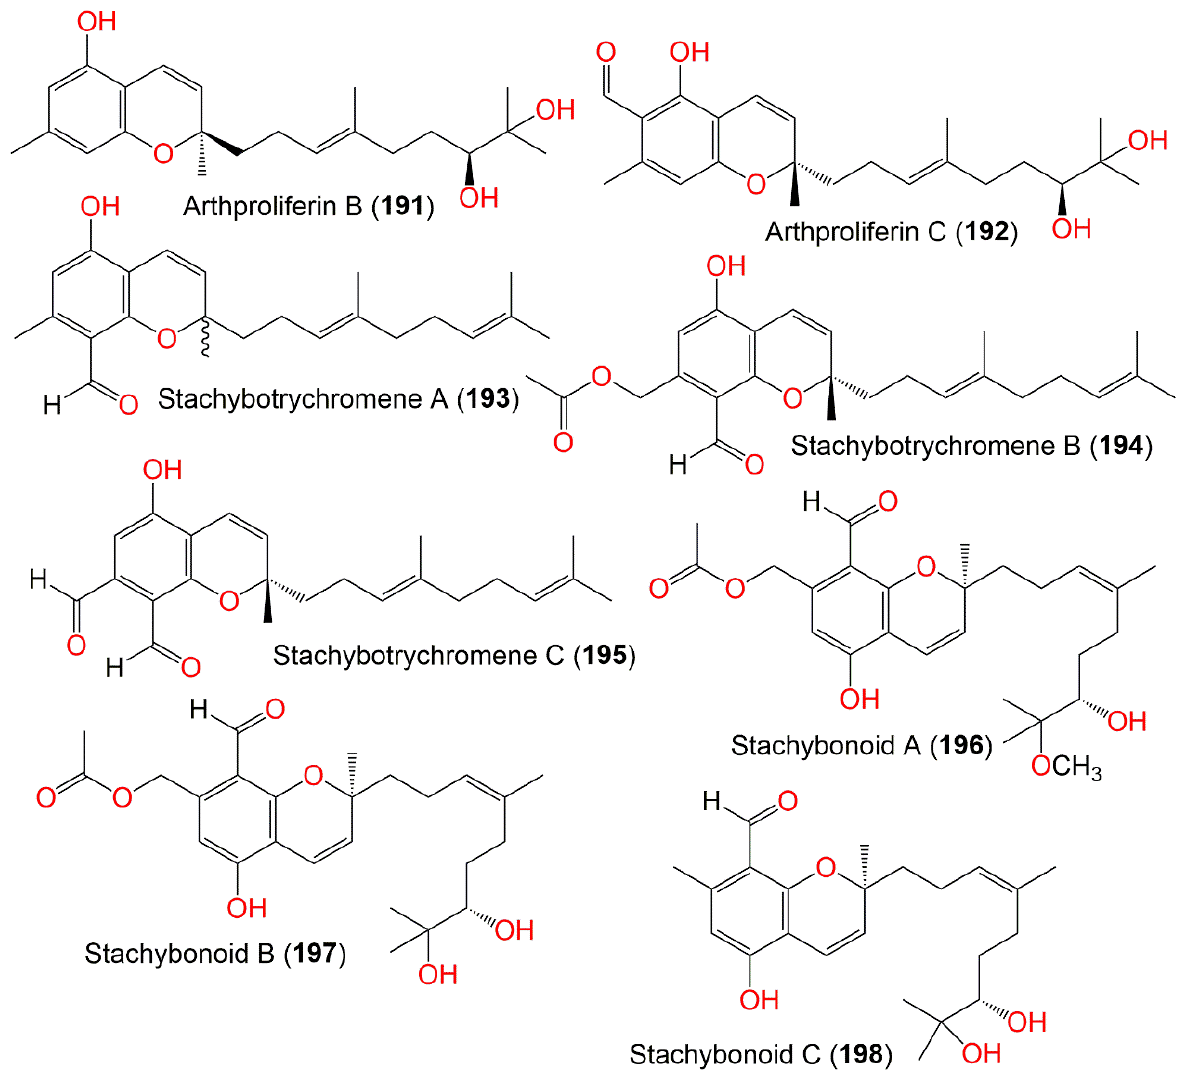
Figure 24. Structures of chromene derivatives ( 191 – 198 ) reported from S. chartarum . It was proposed that they are generated from the addition reaction of farnesyl diphos- phate and orsellinic acid to produce an intermediate ilicicolin B (Scheme 11) [68]). After that, the ilicicolin B prenyl group terminal olefinic bond is epoxidized to produce an inter- mediate. Subsequently, the linkage of the aromatic OH group to C-3 of the prenyl group occurs through electrophilic addition forms 196 – 198 [68]. Sinularia sp.-associated S. chartarum SCSIO4-1201 EtOAc extract yielded undescribed polyketide derivatives, arthproliferins B and C ( 191 and 192 ), that were separated using RP18 CC and HPLC. They were characterized through X-ray, spectroscopic, and ECD richromenic acid previously reported from Rhododendron dauricum [123], except that the C16-C-17 double bond was dehydroxylated, whereas 192 was like 191 but it had an aldehy- dic group at C-2 and 9S configuration. Compounds 192 had no cytotoxic and antimicrobial potential